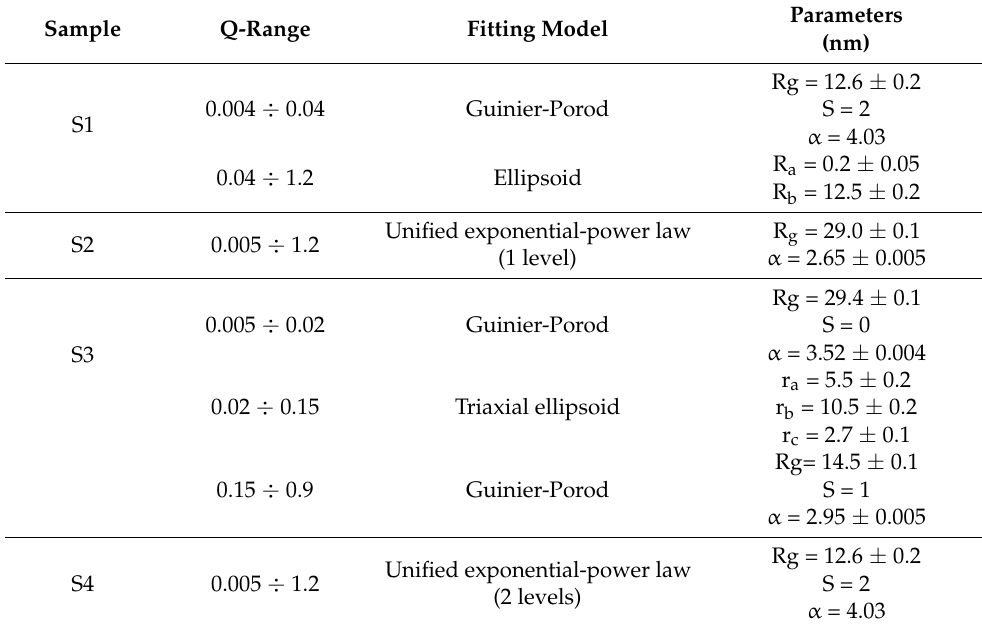
Figure 3. SAXS experimental and fitted curves of S1 ( A ), S2 ( B ), S3 ( C ), and S4 ( D ) samples. Table 3. The morphology and dimensions of the detected nano-objects in the structures of samples